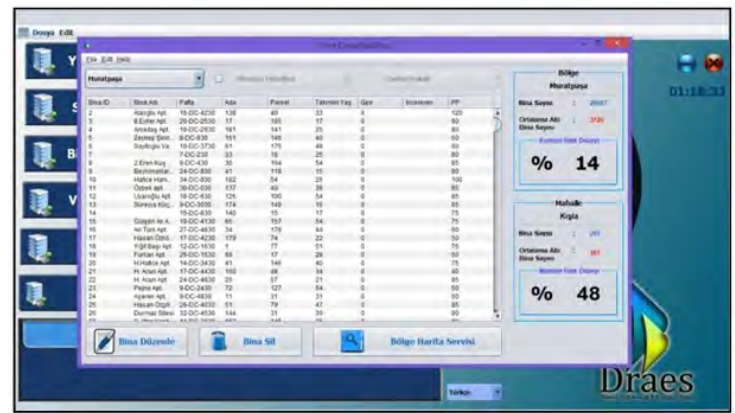
Figure 9. View Building Data Interface